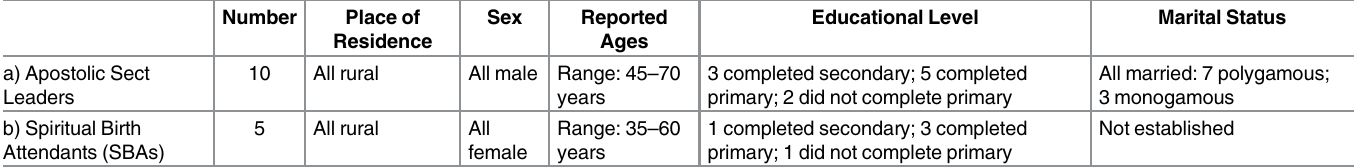
Table 1. Socio-demographic Characteristics of